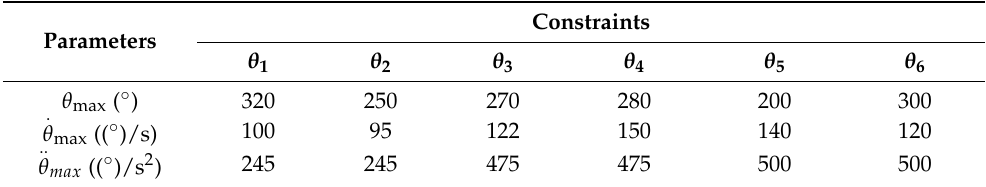
Table 5. Constraints of joints.